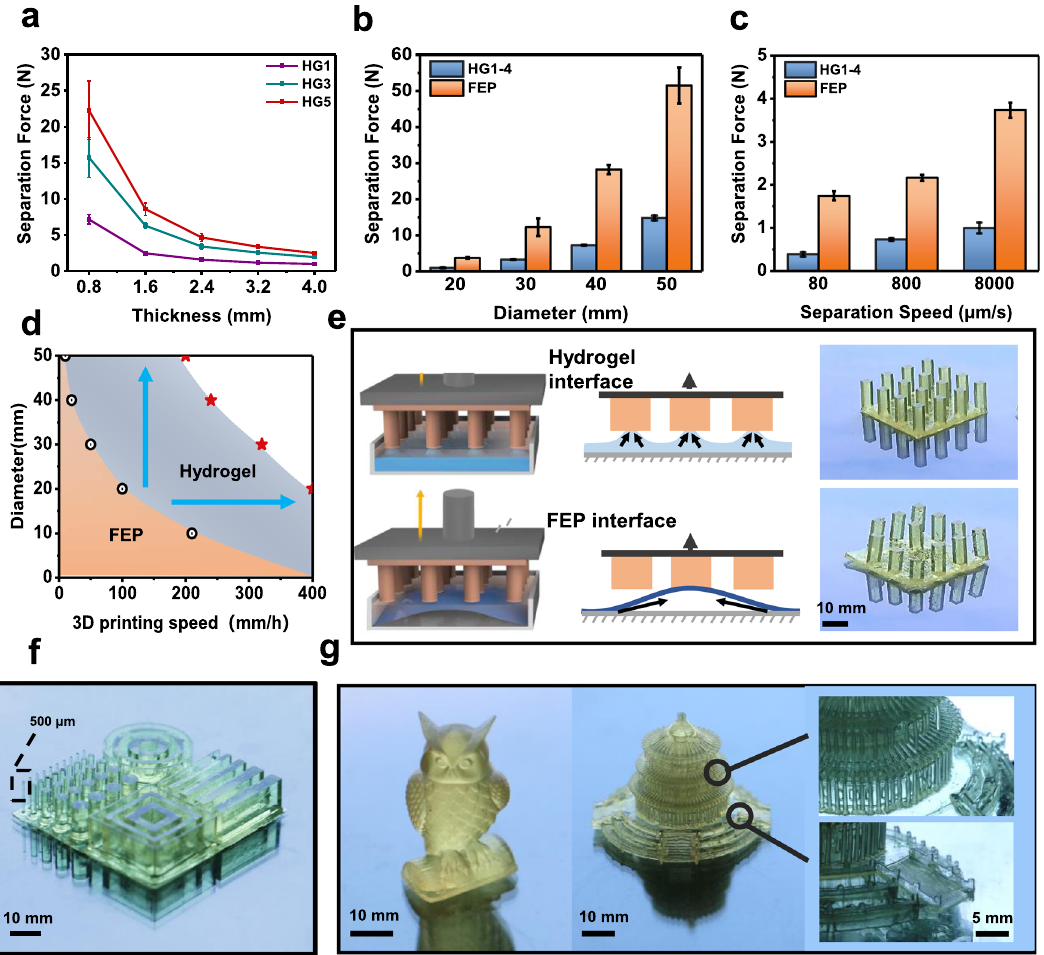
Fig. 2 Evaluation of the separation force and the printability. a Separation force when printing a cylinder of 20 mm diameter using hydrogels with various modulus and thickness. b Separation force when printing cylinders of various diameters using the HG1-4 hydrogel. c Separation force upon various separation speeds. d Achievable productivity when printing cylinders of various diameters using FEP and the hydrogel interface. The back circles and the red stars represent the experimental results using the FEP and hydrogel interfaces respectively. e Scheme of different separation mechanism of FEP and the hydrogel interface when printing discrete object array. f Photograph of a customized testing model printed at a speed of 400 mm/h. g Photographs of the printed owl (400 mm/h) and the Temple of Heaven (200 mm/h). Error bars: Standard Deviation ( n =